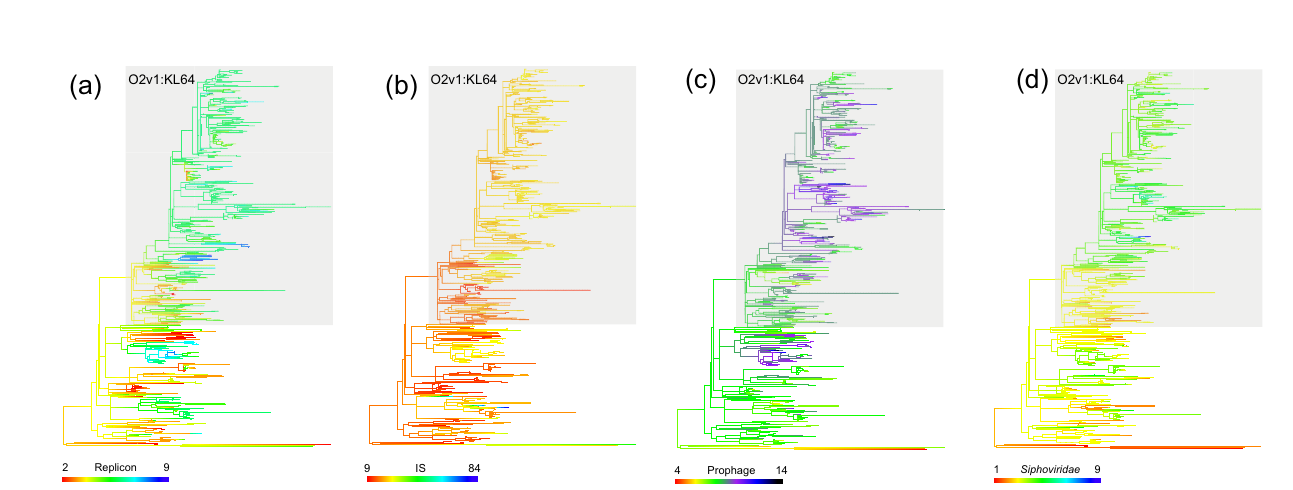
treated with PBS ( a ) or mitomycin C at 8mg/L ( b ) for 1h. Cultures were serially diluted tenfold, spotted at 10ul in rows on LB plates, and incubated overnight at 37°C. Source data are provided as a Source Data fi